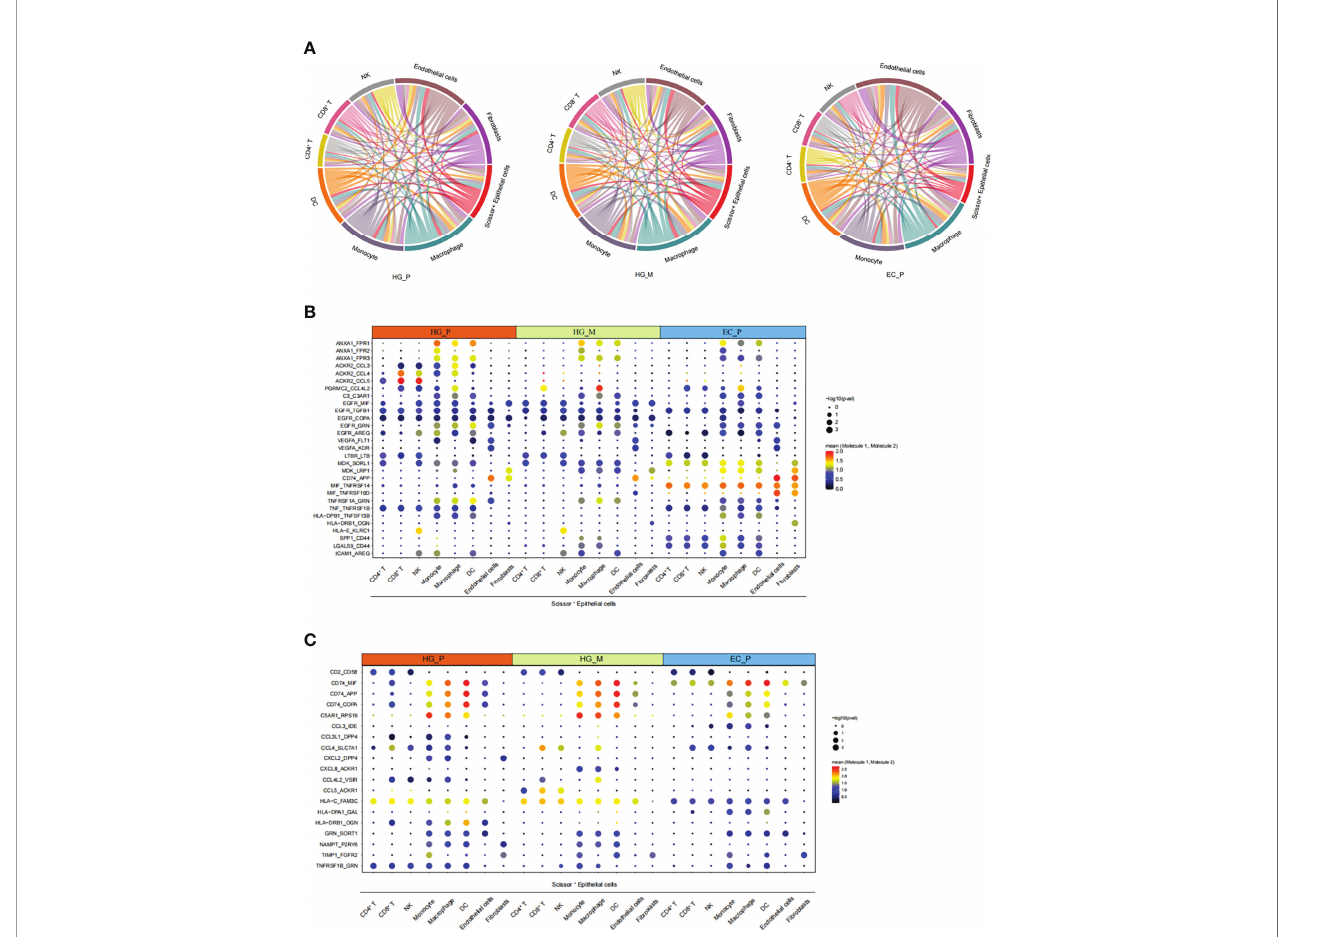
FIGURE 7 | The intricate intercellular interplay in HG_P, HG_M, and EC_P. (A) Circos plot shows the intercellular interactions in HG_P, HG_M, and EC_P. Each line represents an interaction where one end represents a ligand that is expressed in one cell type and the other end represents a receptor that is expressed in another cell type. The thickness of each line corresponds to the number of distinct interacting pairs. (B , C) Dot plot shows the means of the average expression levels and the possibility of occurrence in selective interaction